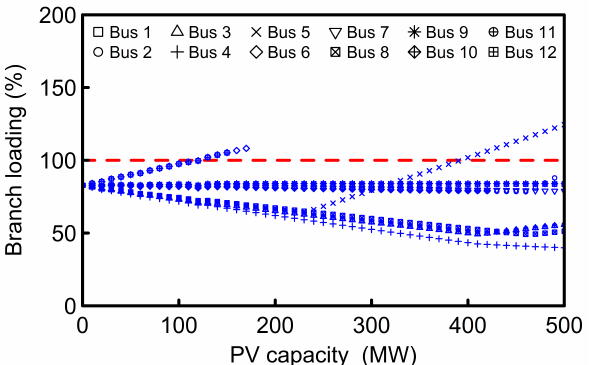
Figure 15. Maximum transmission line loading. Depending on the POI, PV integration may lead to substantial reduction in transmission line loading.